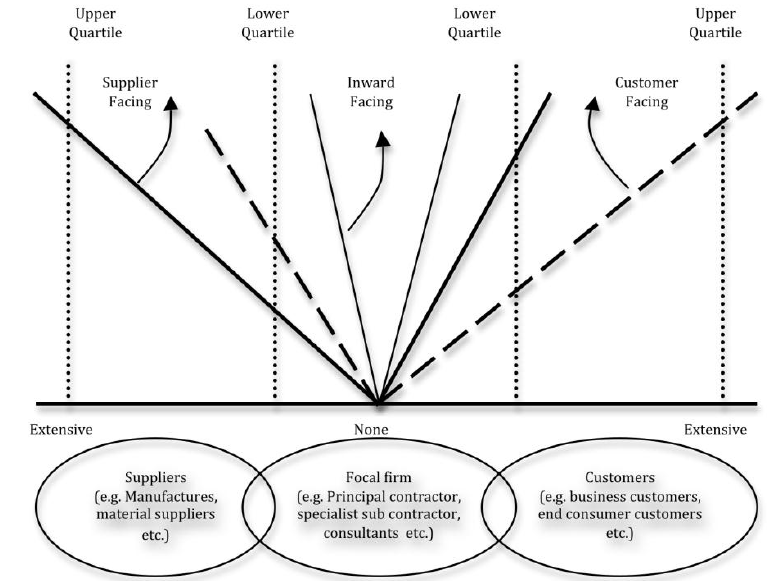
Figure 1 Arcs of integration modified from Frohlich and Westbrook